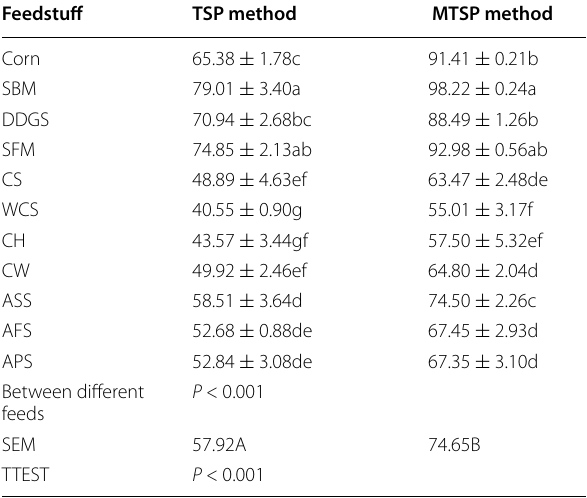
Table 3 The small intestinal digestibility of RUP